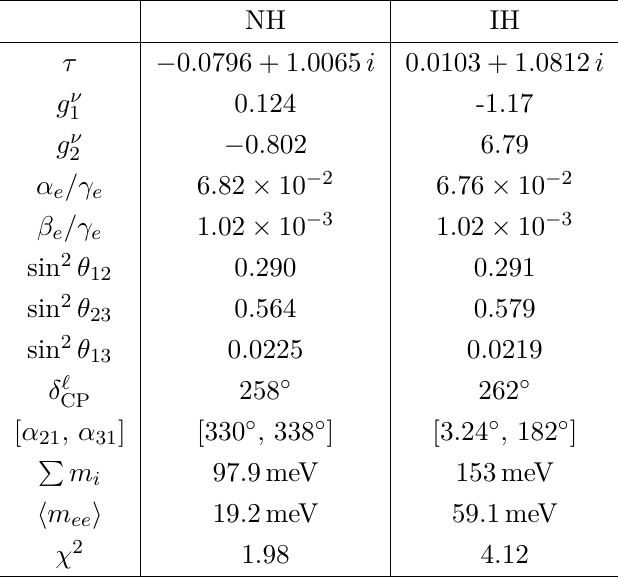
Table 3 . Numerical values of parameters and observables at the sample points of NH and